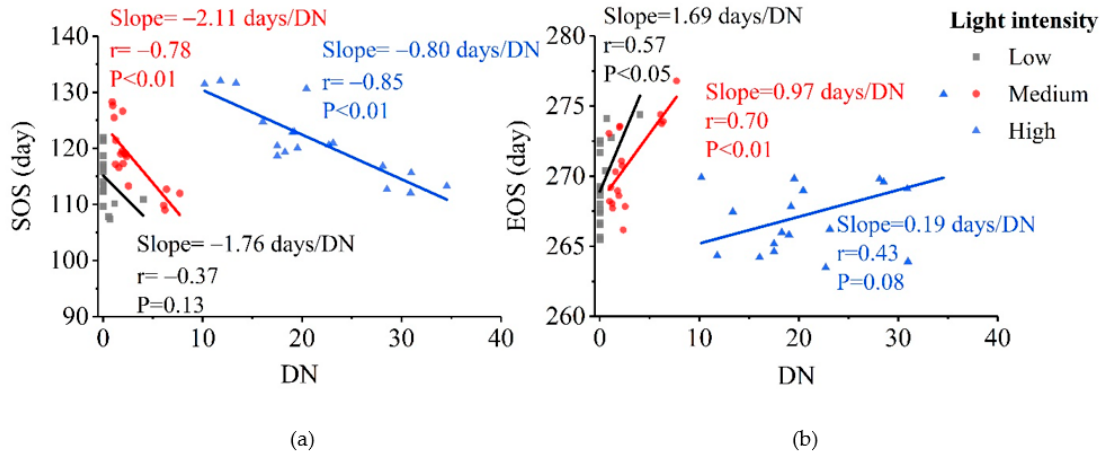
Figure 5. Sensitivity of vegetation phenology to nighttime light intensity across urbanization levels. ( a ) start of the growing season (SOS) and ( b ) end of the growing season (EOS).